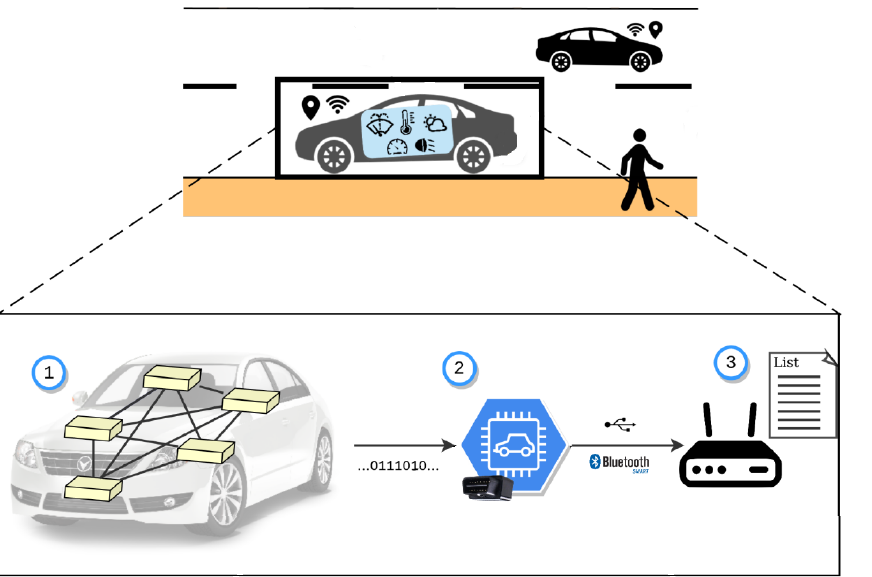
Figure 5. Representation of the vehicular data collection